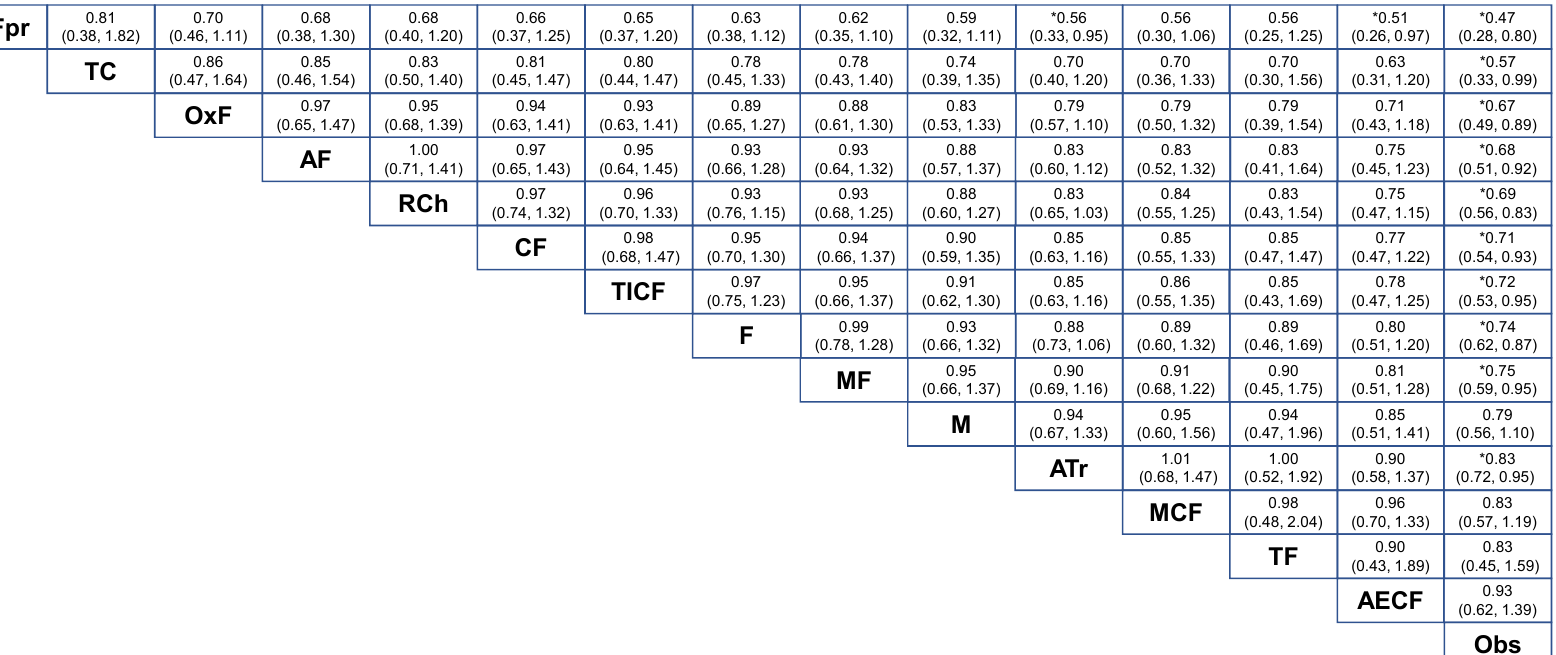
Figure 5. Results of the adjuvant therapy for curatively resected gastric cancer random effects network meta-analysis (NMA-2) for 14 different treatment modalities in terms of overall survival. Relative effects in combined hazard ratios and 95% credible intervals are shown for the combination chemotherapy regimens. The hazard ratio for a given comparison could be read in the intersection of two treatments. The strategies are grouped according to their baseline efficacy compared with observation-alone. All z-tests to compare two treatments were performed two-sided. * p < 0.05. Abbreviations: A = anthracycline; ATr = anthracycline-based triplet; C = cisplatin; E = etoposide; F = fluoropyrimidine; I = irinotecan; M = mitomycin C; Obs = observation; Ox = oxaliplatin; OxFpr = eight cycles